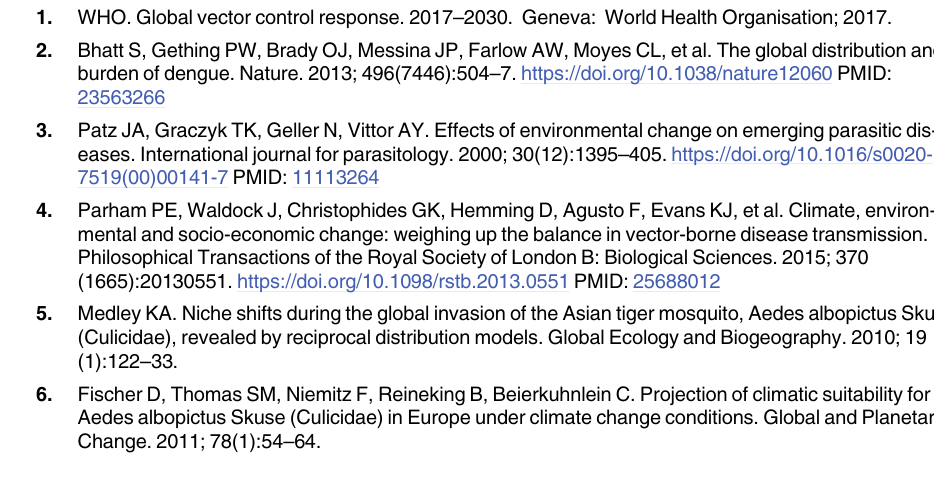
S1 Table. Temperature schedules of incubators used for larval rearing. Temperatures were set to change every hour. Minimum ( � ) and maximum ( indicated once in each